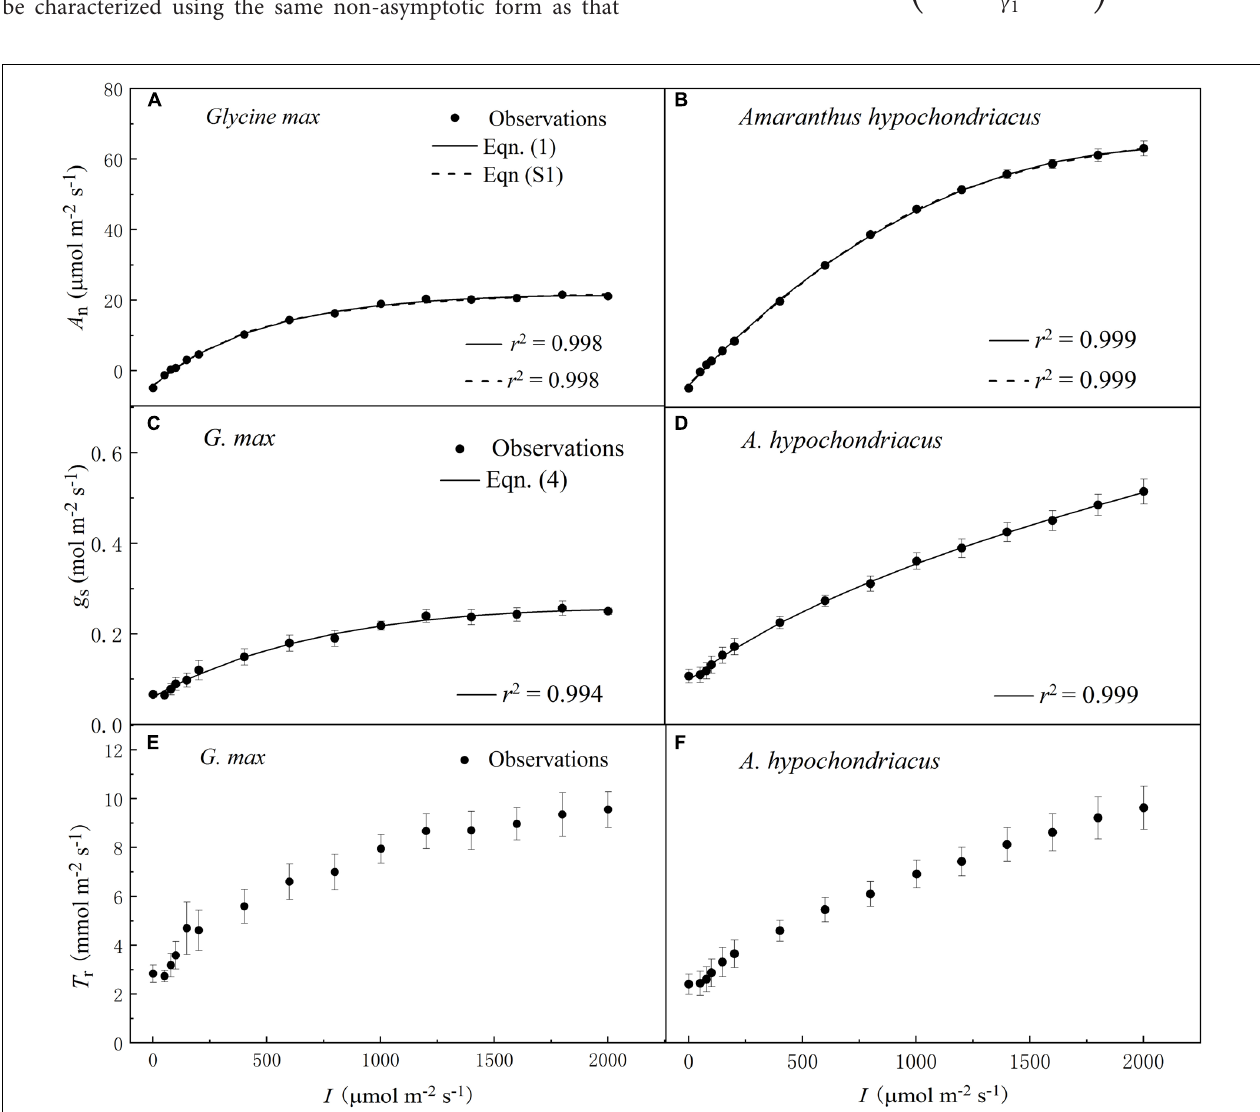
FIGURE 1 | Irradiance ( I ) responses of net photosynthetic rate ( A n ) (A,B) , stomatal conductance ( g s ) (C,D) and transpiration rate ( T r ) (E,F) for C 3 [soybean ( Glycine max )] and C 4 species [grain amaranth ( Amaranthus hypochondriacus )], respectively. In plots (A) and (B) , solid lines were fitted using Eq. 1 and dashed lines were fitted using the non-rectangular hyperbola model (Eq. S1). In plots (C) and (D) , solid lines were fitted using Eq. 4. Data are the mean ± SE ( n =